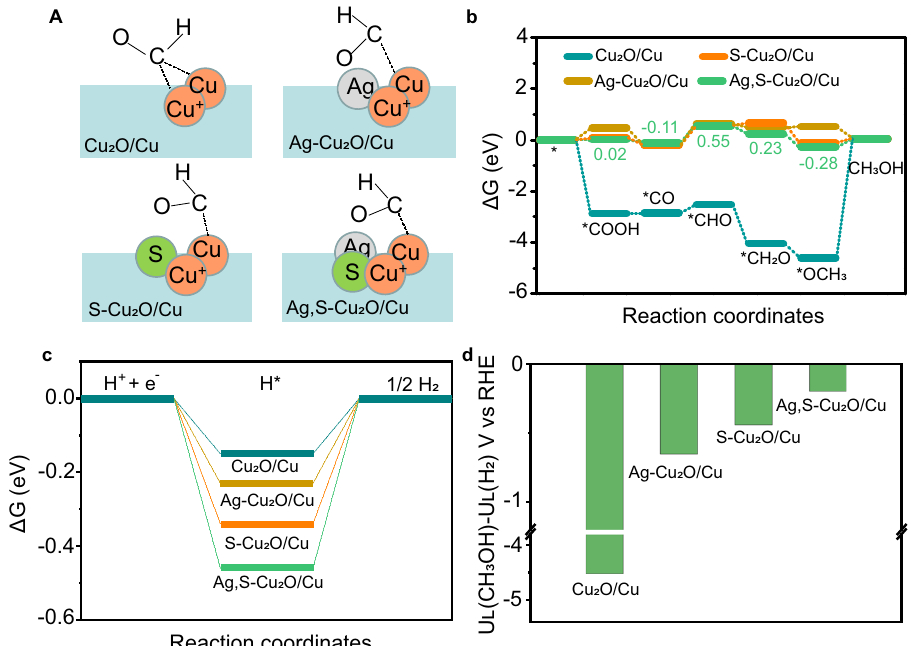
Fig. 4 Theoretical investigation on the CO 2 reduction over Ag,S-Cu 2 O/Cu. a Schematic diagram of * CHO intermediate adsorption over Cu 2 O/Cu, Ag- Cu 2 O/Cu, S-Cu 2 O/Cu, and Ag,S-Cu 2 O/Cu. Reaction free-energy diagrams for the proposed steps of b CO 2 RR to methanol and c HER. d Differences in limiting potentials for CO 2 RR to methanol and HER over Cu 2 O/Cu, Ag-Cu 2 O/Cu, S-Cu 2 O/Cu, and Ag,S-Cu 2